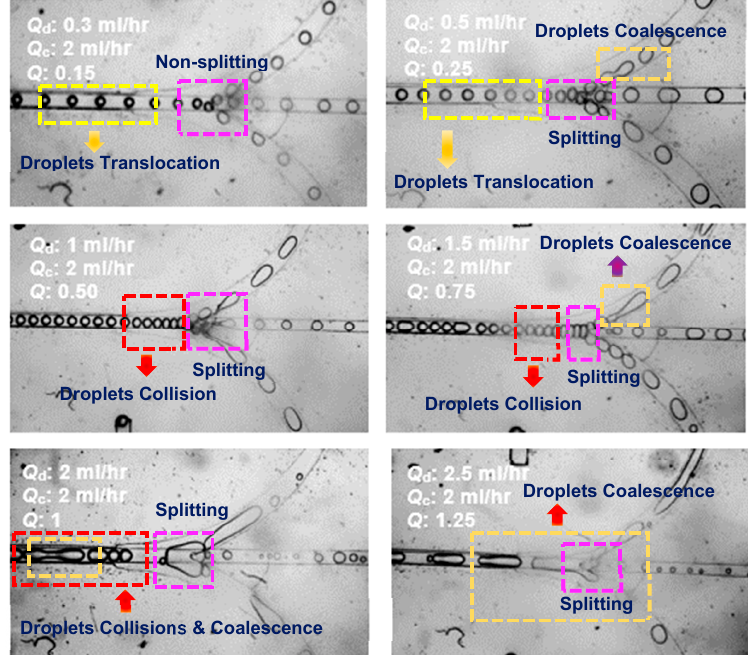
Figure 13. Droplet collision and coalescence phenomena in symmetrical splitting junctions at different flow rate ratio (0.15 < Q < 1.25) by fixing the Q c and varying the Q d .